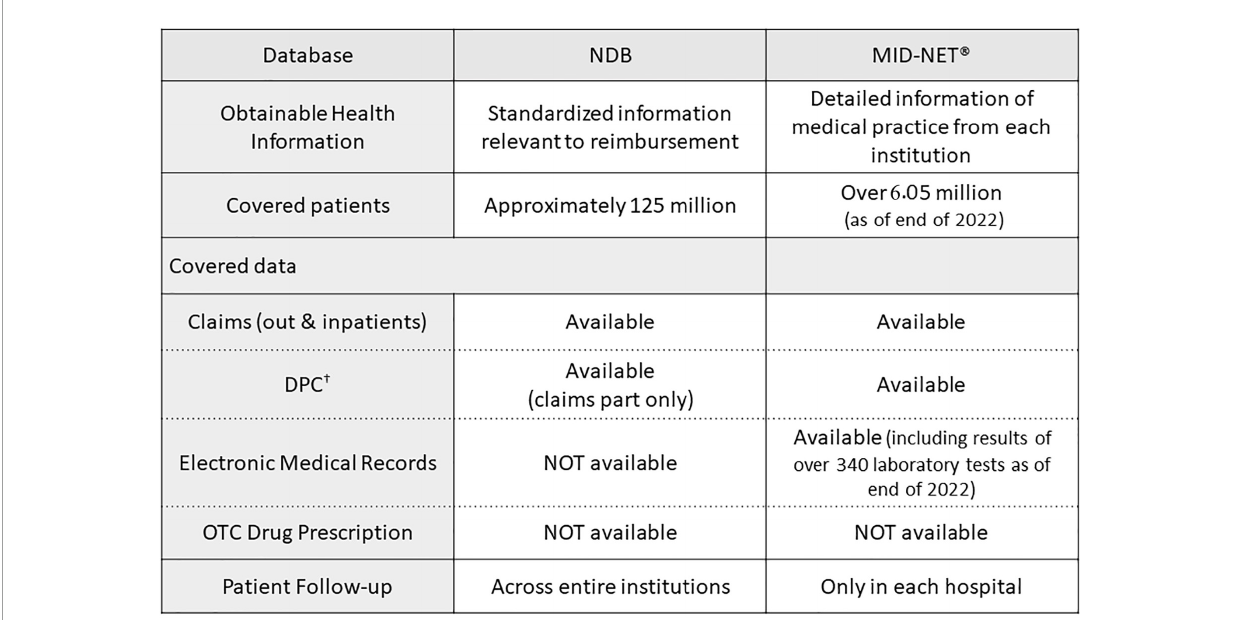
FIGURE2 Comparisons of characteristics between NDB and MID-NET R (cid:13) . † Known as the diagnostic procedure combination (DPC) data, similar to diagnosis related groups (DRGs) in USA. (Acute Inpatient Medical Care System data).